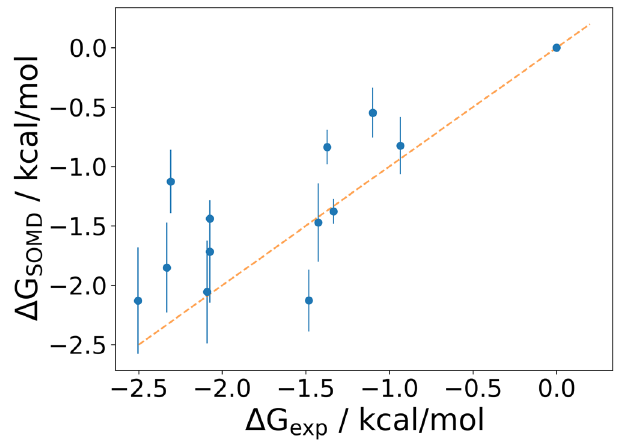
Fig. 4 Comparison between experimental and predicted structures of SARS-CoV-2 main protease (M pro ) inhibitors. Overlay of a 5 and PDBID: 7L11, b 26 and 7L14, c 14 and 7L12, d 21 and 7L13. Crystal structures are coloured in yellow, and modelled binding poses in grey. Root-mean-square distances (RMSD) between predicted and experimental coordinates of atoms in the built R-groups were calculated using RDKit 32 .